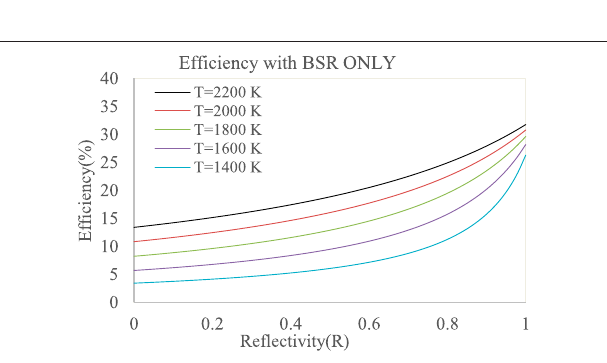
Frontiers in Energy Research |